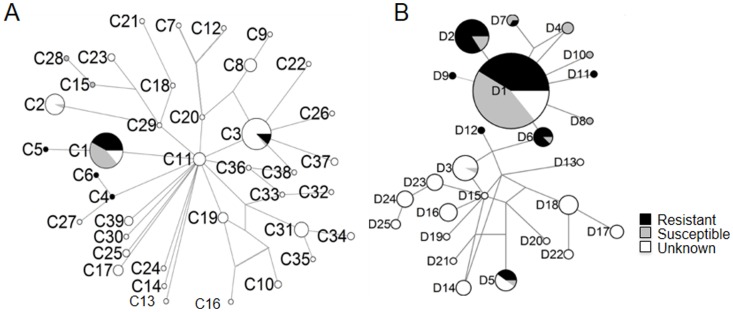
Median-Joining (MJ) mtDNA cyt-b (A) and D-loop (B) haplotype networks and warfarin resistance.Figure details as in Fig. 4, except that here the relative frequency of resistant and susceptible rats is shown. Only animals for which resistance status is known from experimental evidence are included here.